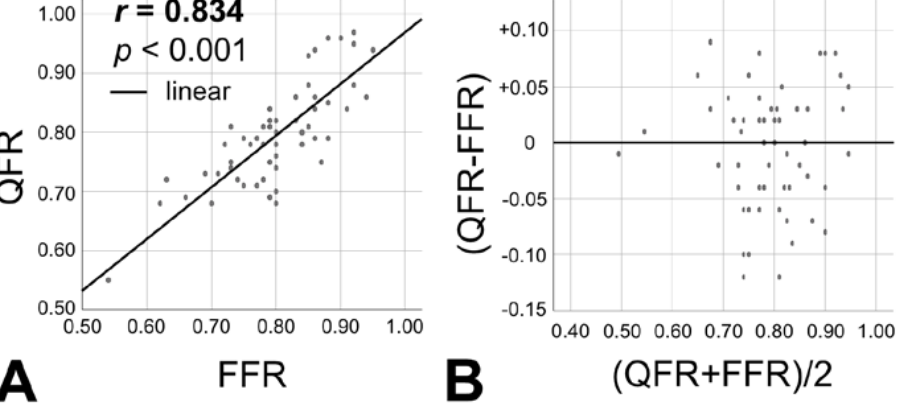
Figure 3 . Association between FFR and QFR. A strong association between the two modalities to assess coronary physiology is present; in ( A ), linear regression is presented; in ( B ), Bland - Altman plot is shown.